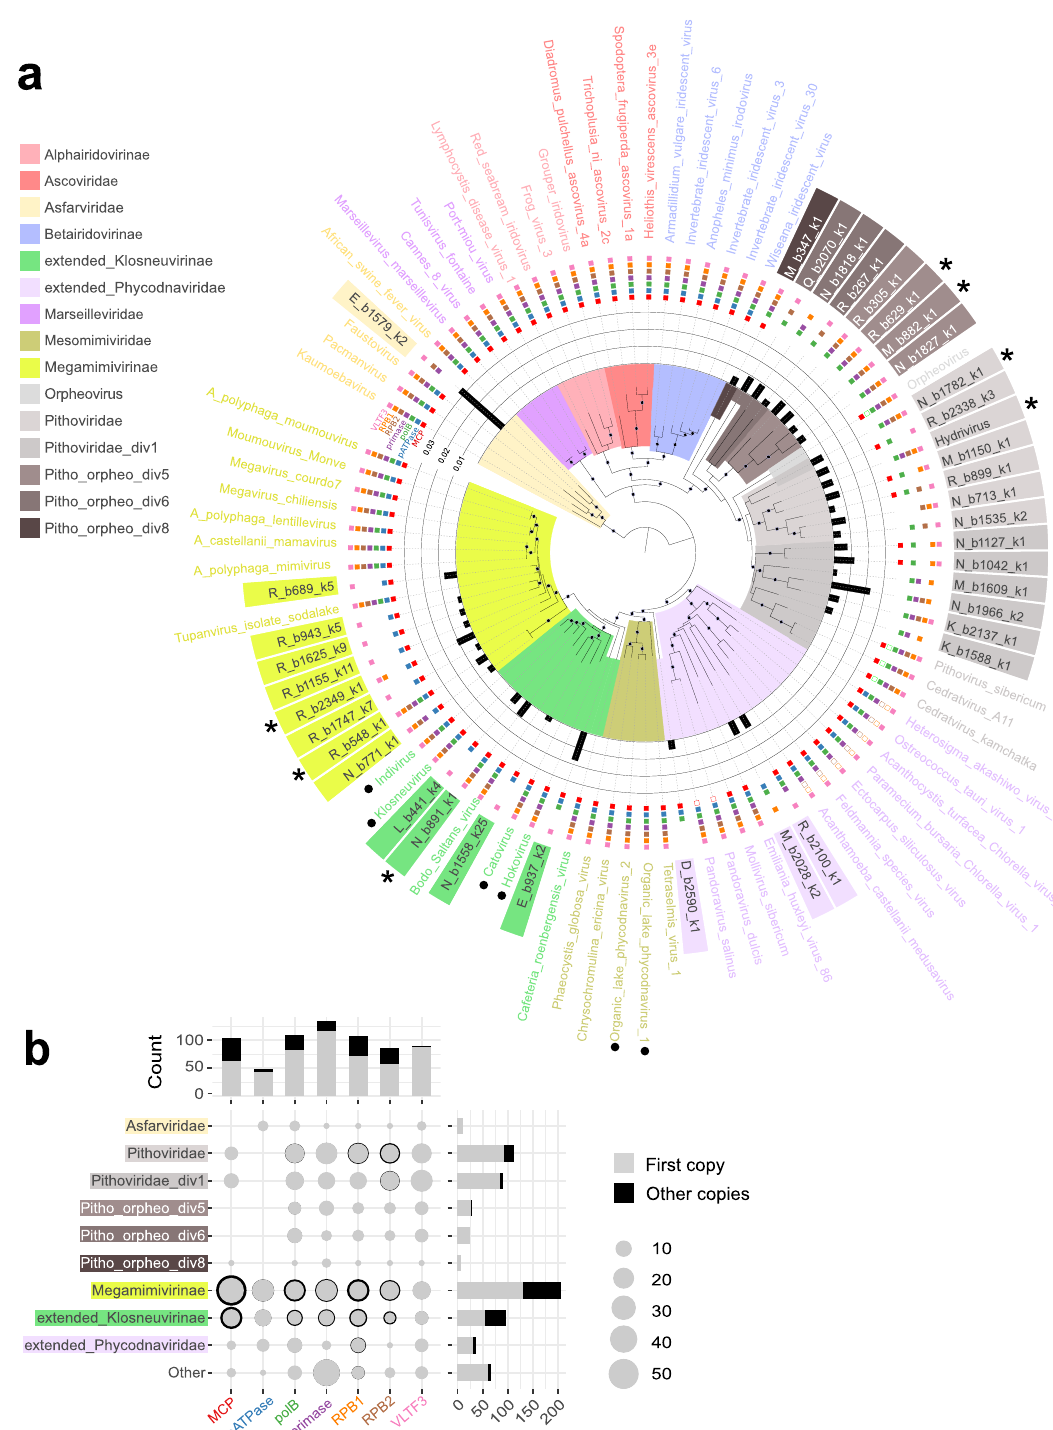
Fig. 3 | Nucleocytoviricota diversity in all samples. a Consensus of 1000 boot- strapped trees calculated by IQ-TREE through a partitioned analysis on 7 marker genes. The tree was performed on permafrost sequences (colored background labels) with more than three marker genes and on reference sequences (white background). The stars indicate the large (>500kb) scaffolds identi fi ed in this study. The models used were the following: LG+F+I+G4 for the packaging ATPase, the RNA polymerase subunits, VT+F+I+G4 for the DNA polymerase, VT+F+G4 for VLTF3 and LG+F+G4 for the MCP. Black dots represent branch bootstrap support ≥ 90%. One should note that reference genomes coming from bins of previous metagenomic studies (marked with a black dot) are less reliable